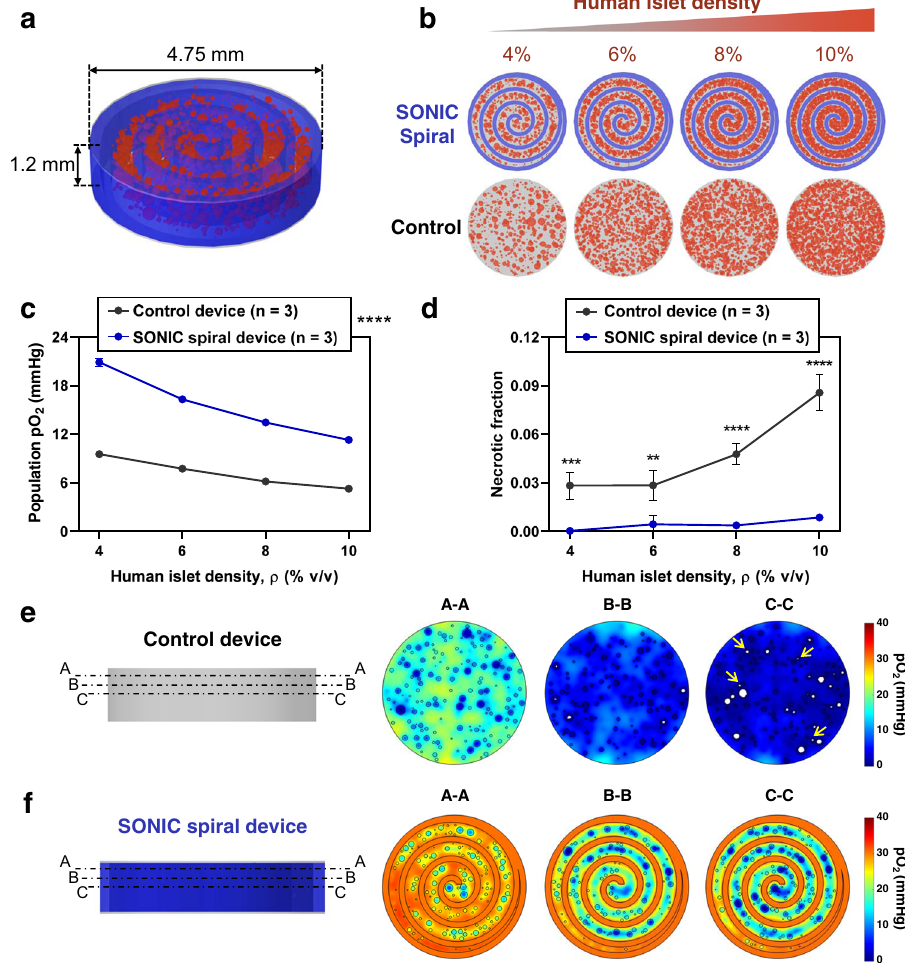
Fig. 7 Computational exploration of a SONIC spiral device for delivering a clinically relevant islet dose. a Annotated schematic of the central section of a hypothetical SONIC spiral device, including the SONIC scaffold (blue) arranged in an Archimedean spiral (with the distance between turns fi xed at 500 μ m) and hydrogel-encapsulated human islets (red). A thickness of 1.2 mm ensures a maximum distance of insulin diffusion of 600 μ m; a diameter of 4.75 mm was used for simulations, representing the central section of a device scaled radially to achieve a suf fi cient encapsulated islet payload. b Schematics showing the SONIC spiral device and scaffold-free control device encapsulating 4%, 6%, 8%, and 10% human islets (volume of islets per volume of device), as tested in the simulations. c , d Simulation predictions of the mean islet population pO 2 ( c ) and fraction of necrosis ( d ) of human islets encapsulated at variable densities in the SONIC spiral device ( n = 3) and the scaffold-free control device ( n = 3); mean ± SD; c: **** p < 0.0001 (control device versus SONIC spiral device at all islet densities); d: ***p = 0.0004 (control device versus SONIC spiral device at 4% islet density), ** p = 0.0018 (control device versus SONIC spiral device at 6%), **** p < 0.0001 (control device versus SONIC spiral device at 8% and 10% islet densities). Statistical tests in c and d were analyzed via a two-way ANOVA followed by Sidak ’ s post hoc p -value adjustment for multiple comparisons. e , f Surface plots of pO 2 gradients (right) at selected cross-sections (left; labelled A-A, B-B, and C-C) in the control device ( e ) and the SONIC spiral device ( f ) at 8% human islet loading density showing signi fi cantly higher pO 2 and negligible necrosis in the SONIC spiral device compared to the control device (white regions in the islets represent necrosis, and yellow arrows in C-C section indicate necrosis even in some small